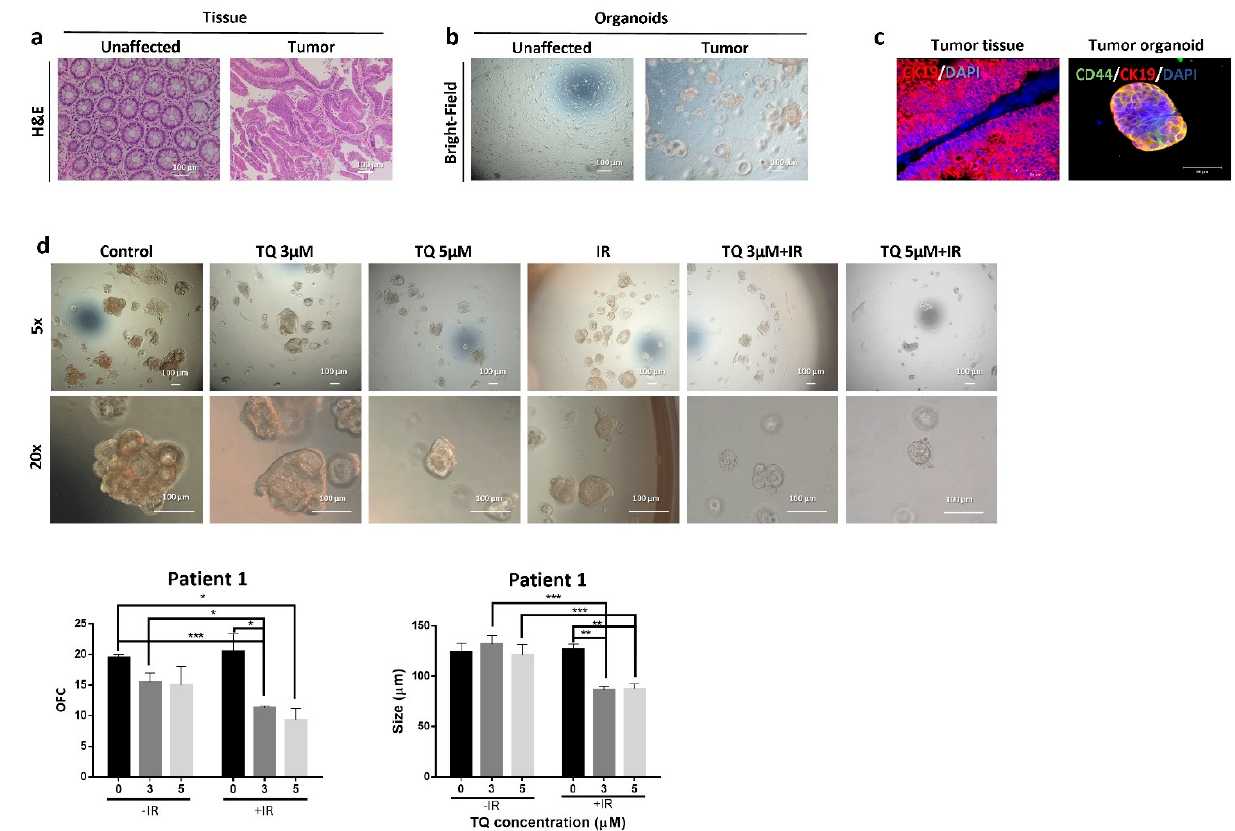
Figure 6. TQ radiosensitizes patient 1-derived rectal cancer organoids and reduces their organoid- forming ability and size. ( a ) Representative images of H&E stain of unaffected rectum and rectal cancer tissue from patient 1. ( b ) Representative bright-field images of organoids derived from unaffected rectum and rectal cancer samples (patient 1). ( c ) Immunofluorescent images of rectal tumor issues and organoids stained for CD44 and CK19. Images were obtained using confocal microscopy. ( d ) Representative bright-field images of organoids derived from rectal cancer patient 1 sample and treated with TQ (3 and 5 µ M), radiation (2 Gy), or combinations. Fresh unaffected and tumor tissues were digested, and single cells were resuspended in 90% Growth Factor reduced Matrigel and 10% serum-free colon media and allowed to grow in serum-free colon media (without treatment). Generated organoids are referred to as G1 organoids. Organoids were propagated to G2 and treated with TQ, IR, or combinations. OFC and size were calculated, and average values were reported as mean ± SEM (* p < 0.05, ** p < 0.01, *** p < 0.001). Images were visualized